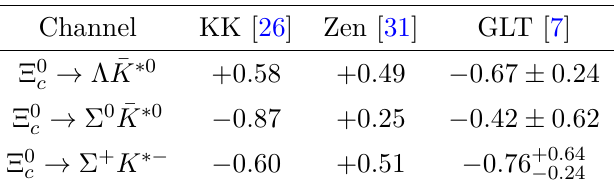
→ B n V decays based on the c